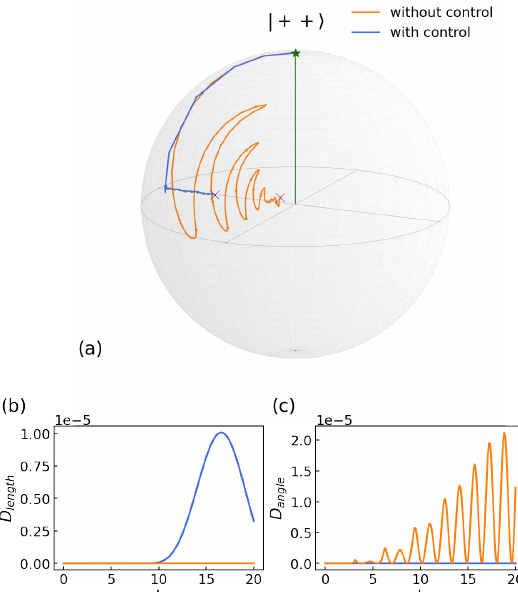
Figure 12: (a) Generalised Bloch vectors showing the evolution of the two-qubit states for interaction strength estimation with XX coupling. The | ++ 〉 probe state is aligned to the + z direction as a reference state. The optimised control fields applied are shown in Fig. 11(b). The green star and pink cross indicate the start and end of the evolution respectively. The (b) difference in length and (c) angle between the Bloch vectors of the states ρ and ρ are plotted for the controlled and uncon- g g + δ g